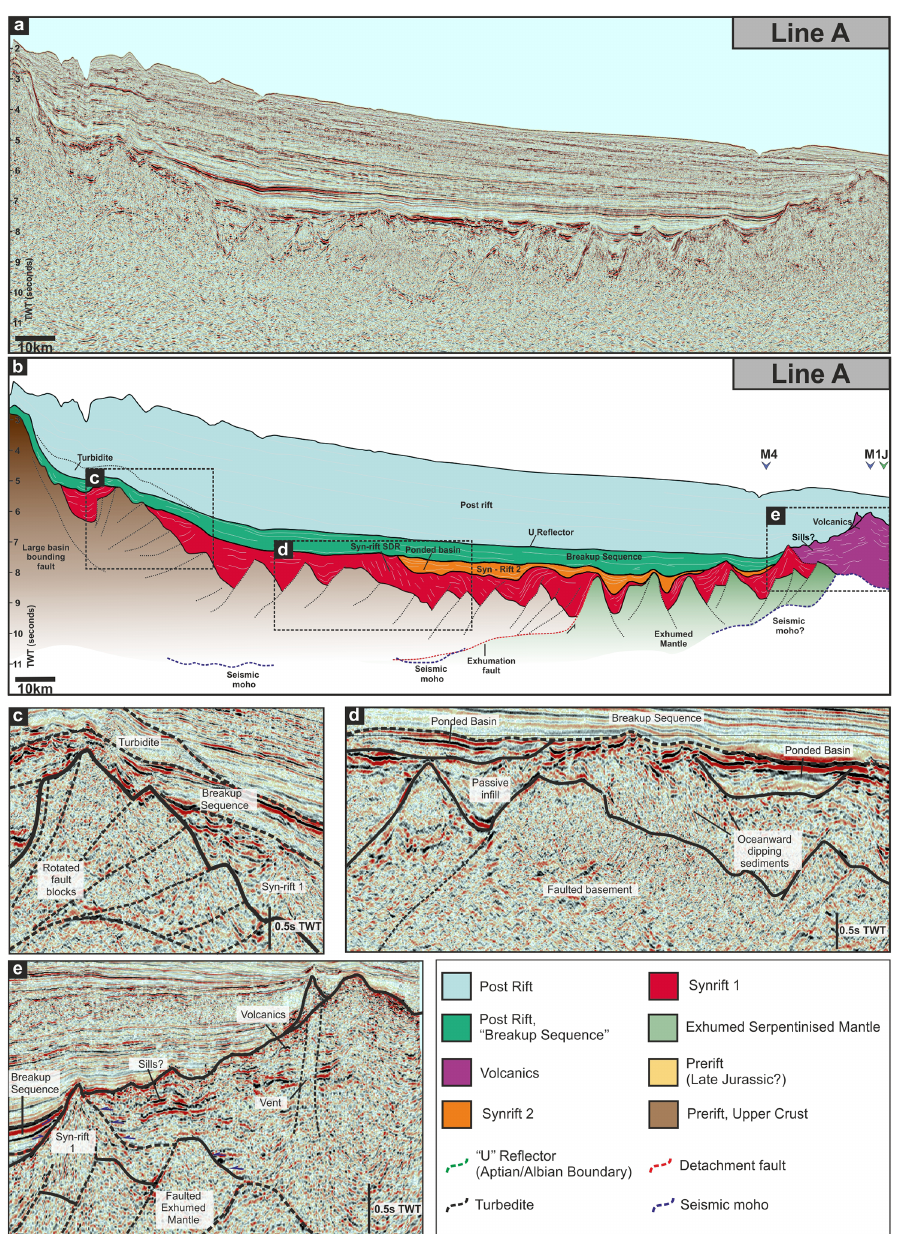
Figure 5. (a–b) Un-interpreted and interpreted seismic reflection profile (“Line A”) from the southern Southern Newfoundland Basin. Interpretation shows the basement structure and sedimentary units. (c) Basement structure at the base of the continental slope. (d) Oceanward- dipping reflectors in syn-rift 1 sediments. (e) Volcanic edifice present in the proto-oceanic zone with associated sills and magmatic vents. All data courtesy of